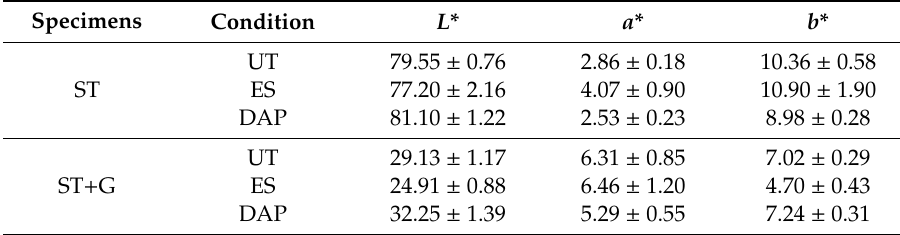
Figure 9. Comparison between the surface appearance of “DAP”-treated (left), “UT” (middle), and “ES”-treated (right) stone (“ST”) and stone+guano (“ST+G”) specimens. DAP = diammonium hydrogen phosphate; UT = untreated; ES = ethyl silicate. Table 1. Color parameters of untreated and treated specimens.